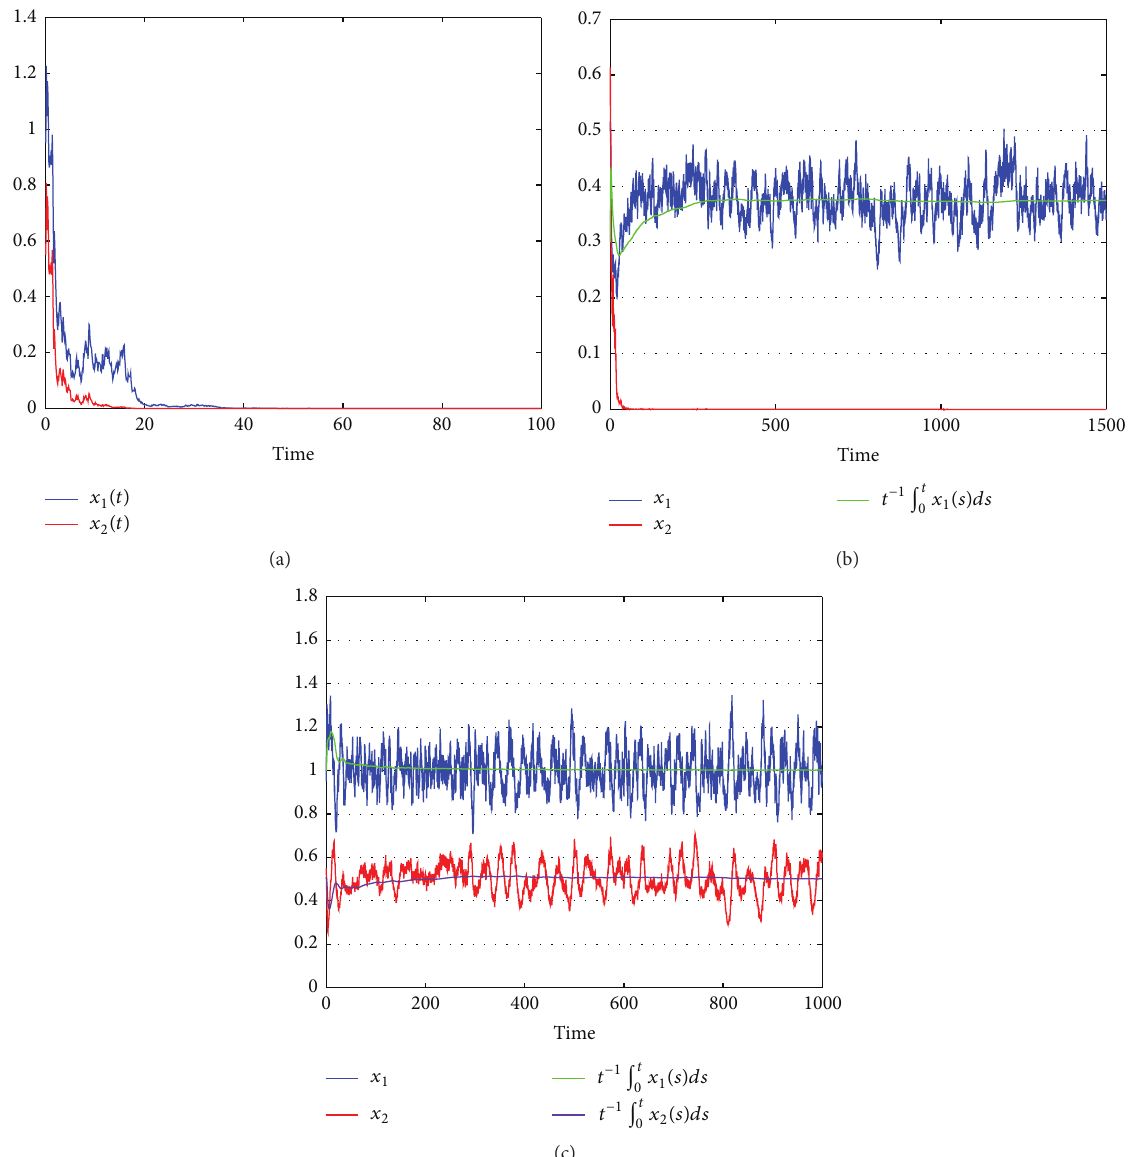
Figure 1: Solutions of system (3) for 𝑟 10 = 0.85 , 𝑟 20 = 0.05 , 𝑟 11 = 𝑟 21 = 1 , 𝑎 11 = 0.4 , 𝑎 12 = 0.4 , 𝑎 21 = 0.3 , 𝑎 22 = 0.3 , 𝜏 1 = 3 , 𝜏 2 = 8 , 𝛼 2 2 = 0.1 , = 𝑔 = 𝑚 = 0.1 , 𝑖 = 1, 2 , ℎ = 0.5 , 𝑏 = 0.6 , 𝛾 = 12 , 𝑥 𝑘 𝑖 𝑖 𝑖 /2 = 0.82 ; (b) is with 𝛼 2 /2 = 0.65 ; (c) is with 𝛼 2 𝛼 2 1 1